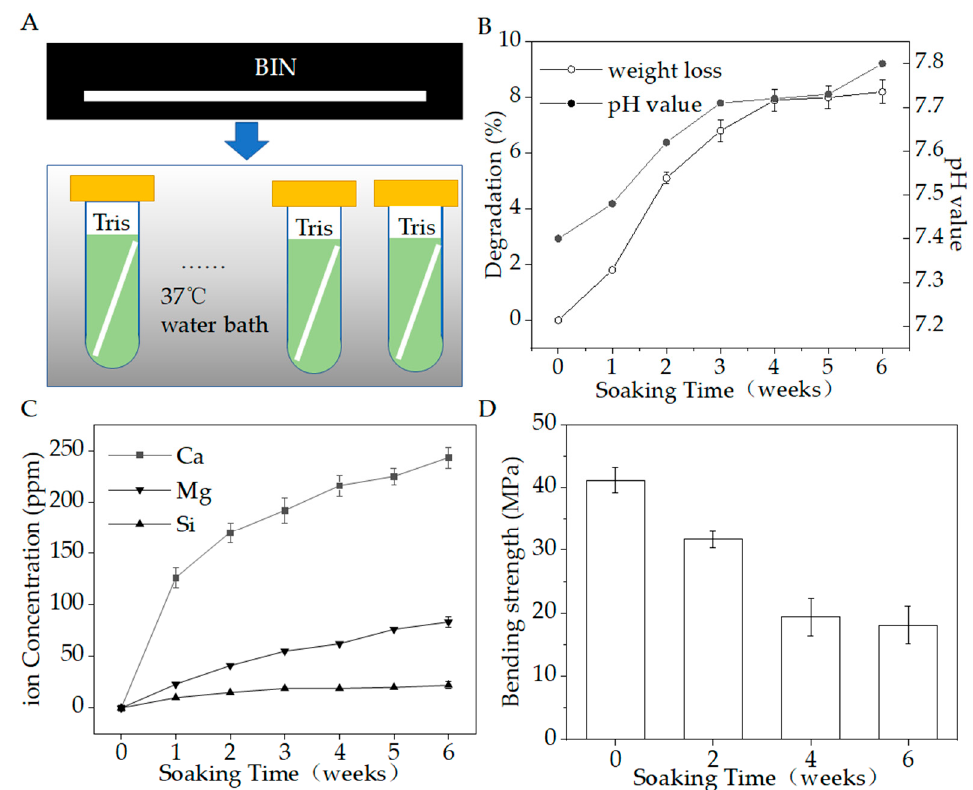
Figure 7. ( A ) Degradation in vitro. ( B ) Weight loss (%) and pH value during the degradation period. ( C ) Ions release during the degradation period. ( D ) Bending strength during the degradation period ( p < 0.05).